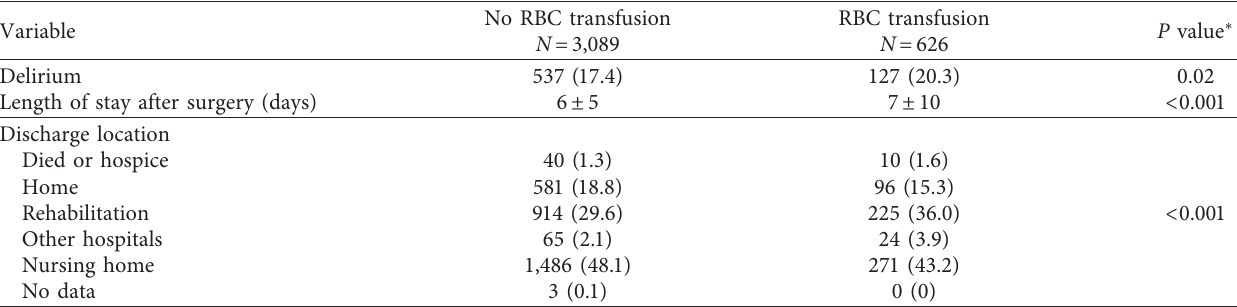
Table 4: Outcomes for patients in the IPTW